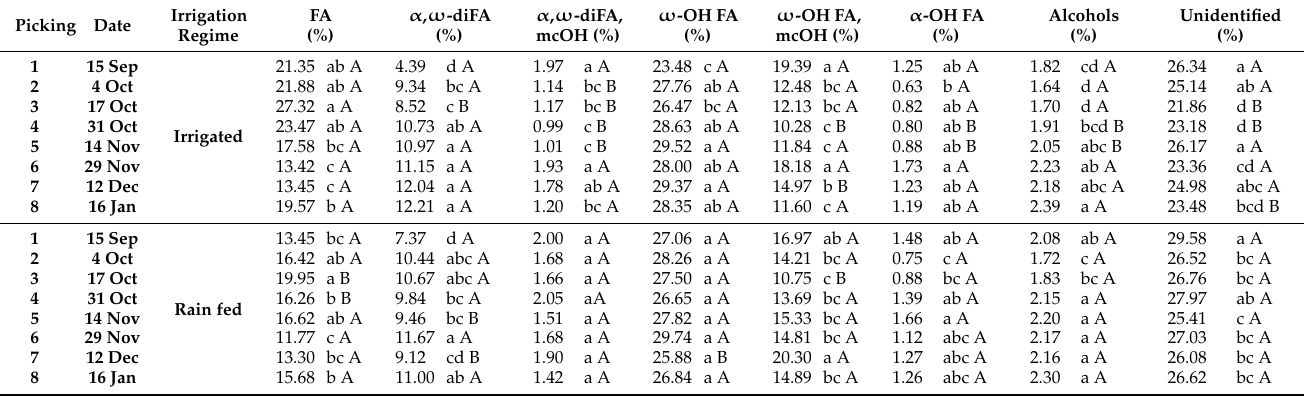
Table 5. Composition of cutin monomers (relative % over total cutin) in fruit cuticles isolated during ripening of irrigated and non-irrigated ‘Arbequina’